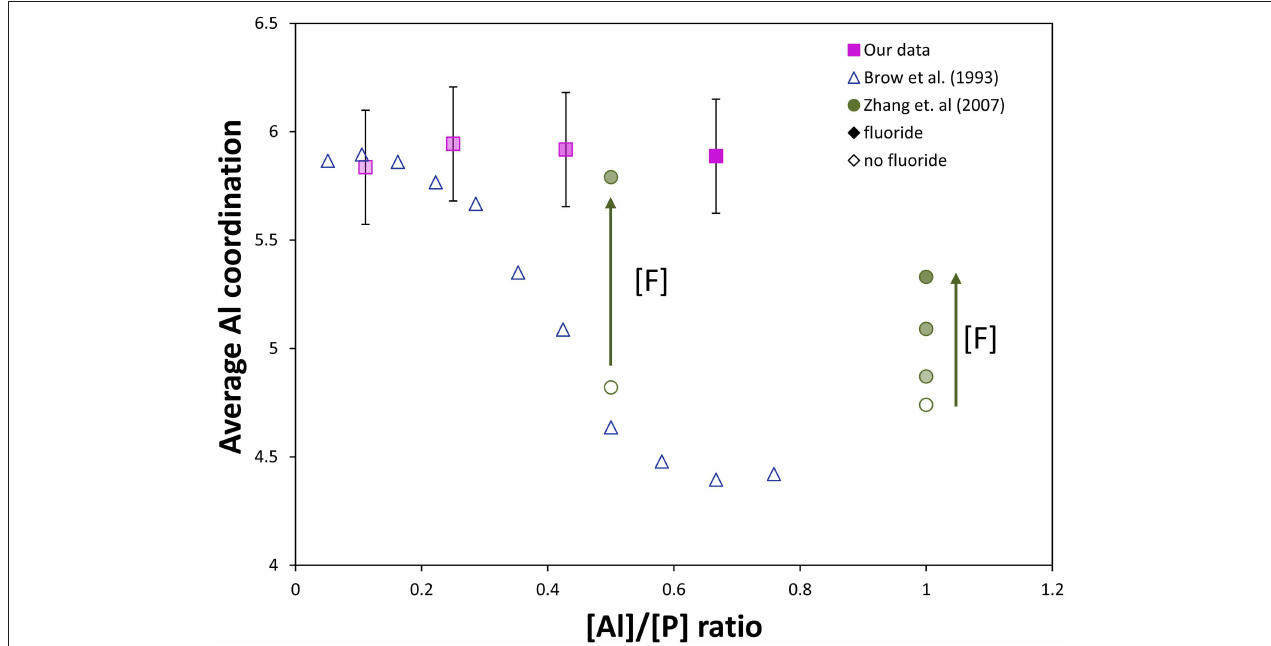
FIGURE 6 | Comparison of our NMR data to literature NMR data from Brow et al. (1993) and Zhang et al. (2007, 2013). Effect of [Al]/[P] ratio and fluorine content on the average Al coordination in aluminophosphate and fluoroaluminophosphate series (completely shaded markers have the most fluoride, [F]/[Al + P] = 1.2, and unshaded markers have no fluoride content, [F]/[Al + P] = 0). Without fluorine, substantial Al[6] only forms at very low [Al]/[P], ≤ 0.3. The effect of fluorine content on the Al coordination can be observed: addition of fluoride ([F]/[P] = 0.5) forces most Al content into Al[6] despite a much higher [Al]/[P] ( ∼ 0.5) compared with only aluminophosphate, while at sufficiently high [Al]/[P] ( ∼ 1), much more fluoride content can be added without forcing all aluminum into 6-fold coordination (some remains as Al[4] and Al[5]).